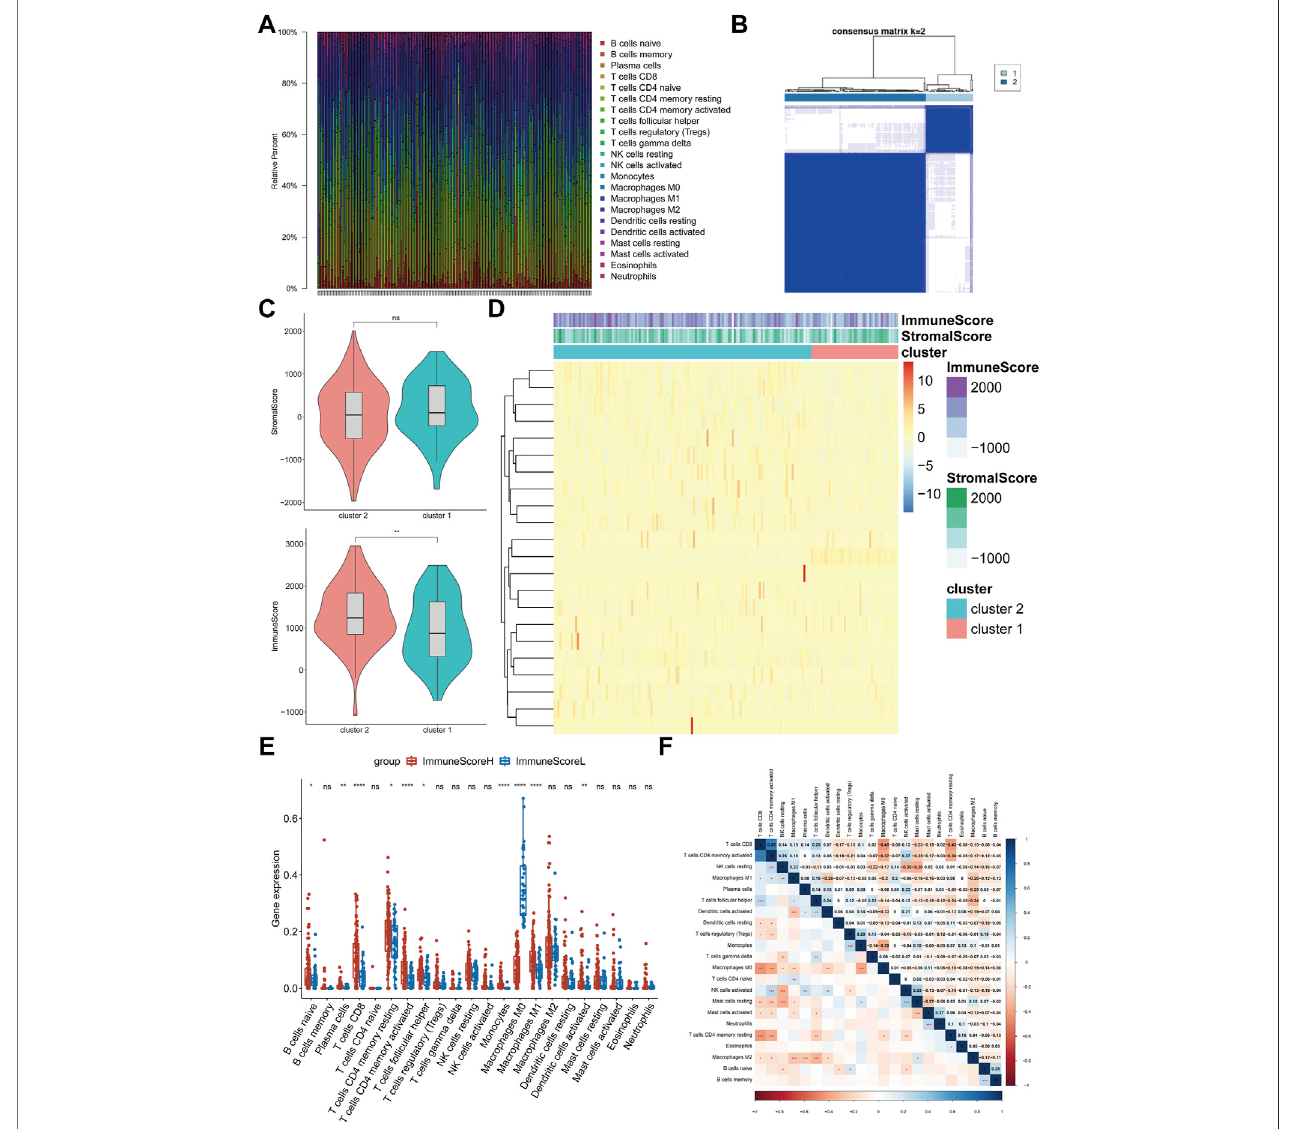
FIGURE1| Evaluationand visualizationofimmunecellin fi ltration inBLCA. (A) Frequencies ofimmunecellsinallsamples.Stackedbar chartsbysamplename( n = 178). (B) Clustering heatmap showing theclustersat k =2. (C) Differences between the immune scoresofcluster 1and cluster2. (D) Abundances ofin fi ltratingimmune cell subsets based on ssGSEA between cluster 1 and cluster 2. (E) Differences in the in fi ltration levels of the 22 immune cell subsets between ImmuneScoreH and ImmuneScoreL. (F) Correlation matrix of all 22 immune cell frequencies. Some immune cells were negatively related (shown in blue), and others were positively related (shown in red). The darker the color, the higher the correlation was. * p < 0.05, ** p < 0.01, *** p < 0.001, **** p < 0.0001, ns < 1.